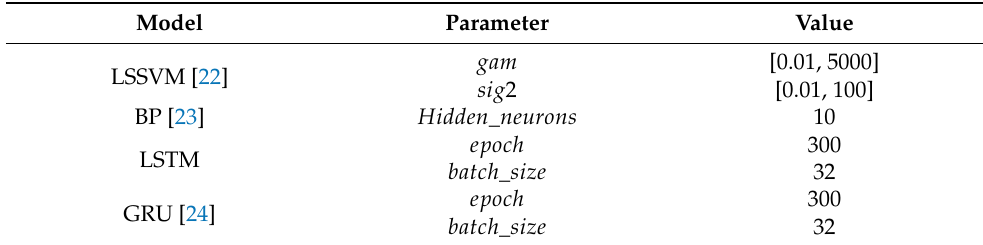
Table 3. The parameters setting of the compared models.